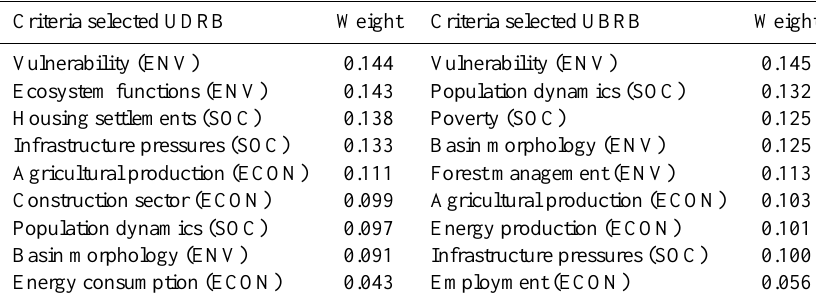
Table 1. Criteria selected by LAs from the Integrated Indicators